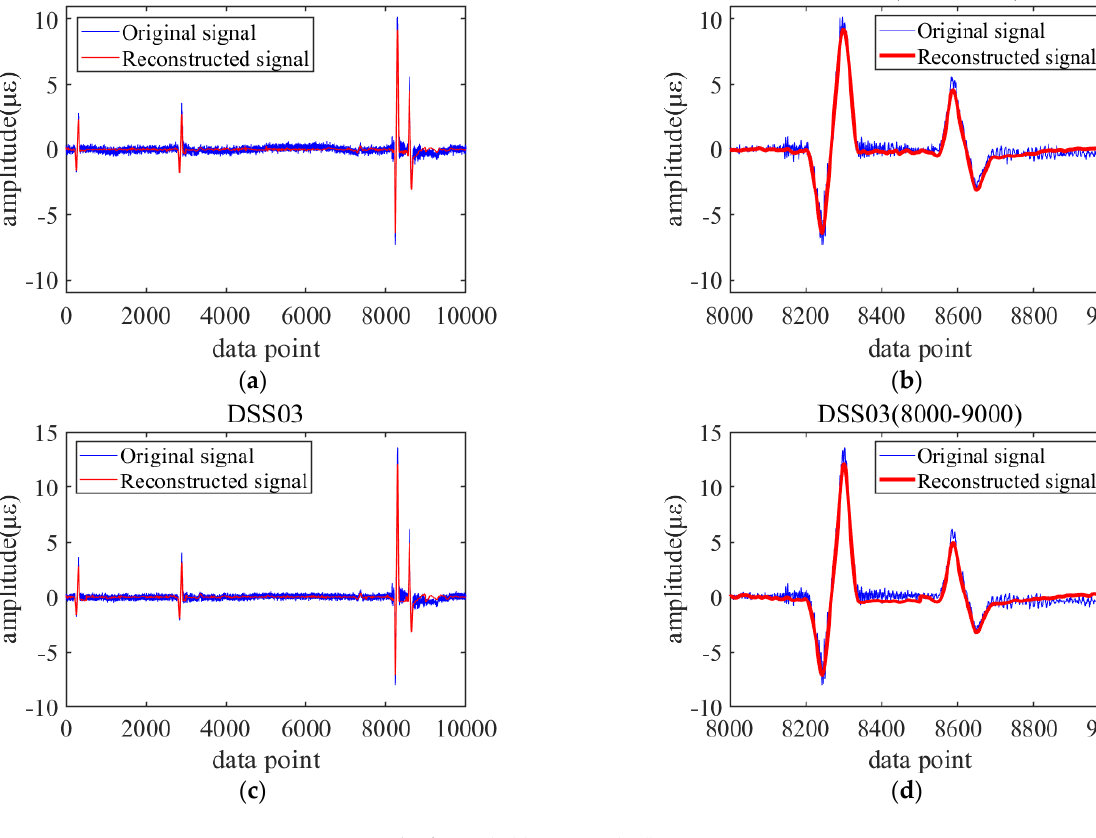
Figure 16. Signal sifting: ( a , b ) DSS02, ( c , d ) DSS03.